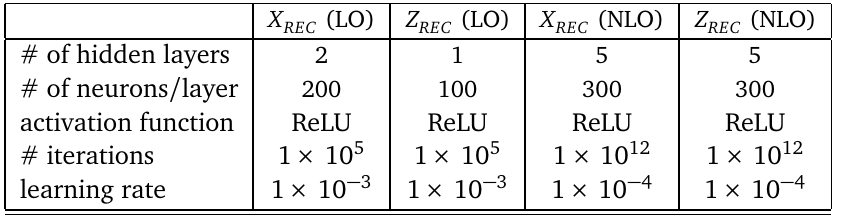
Table 2: Architecture for the MLP best fit parameters for the reconstruction of the mo- mentum fractions at LO in QCD: X and for the momentum fractions at NLO QCD + LO QED: X (fourth and fifth columns).